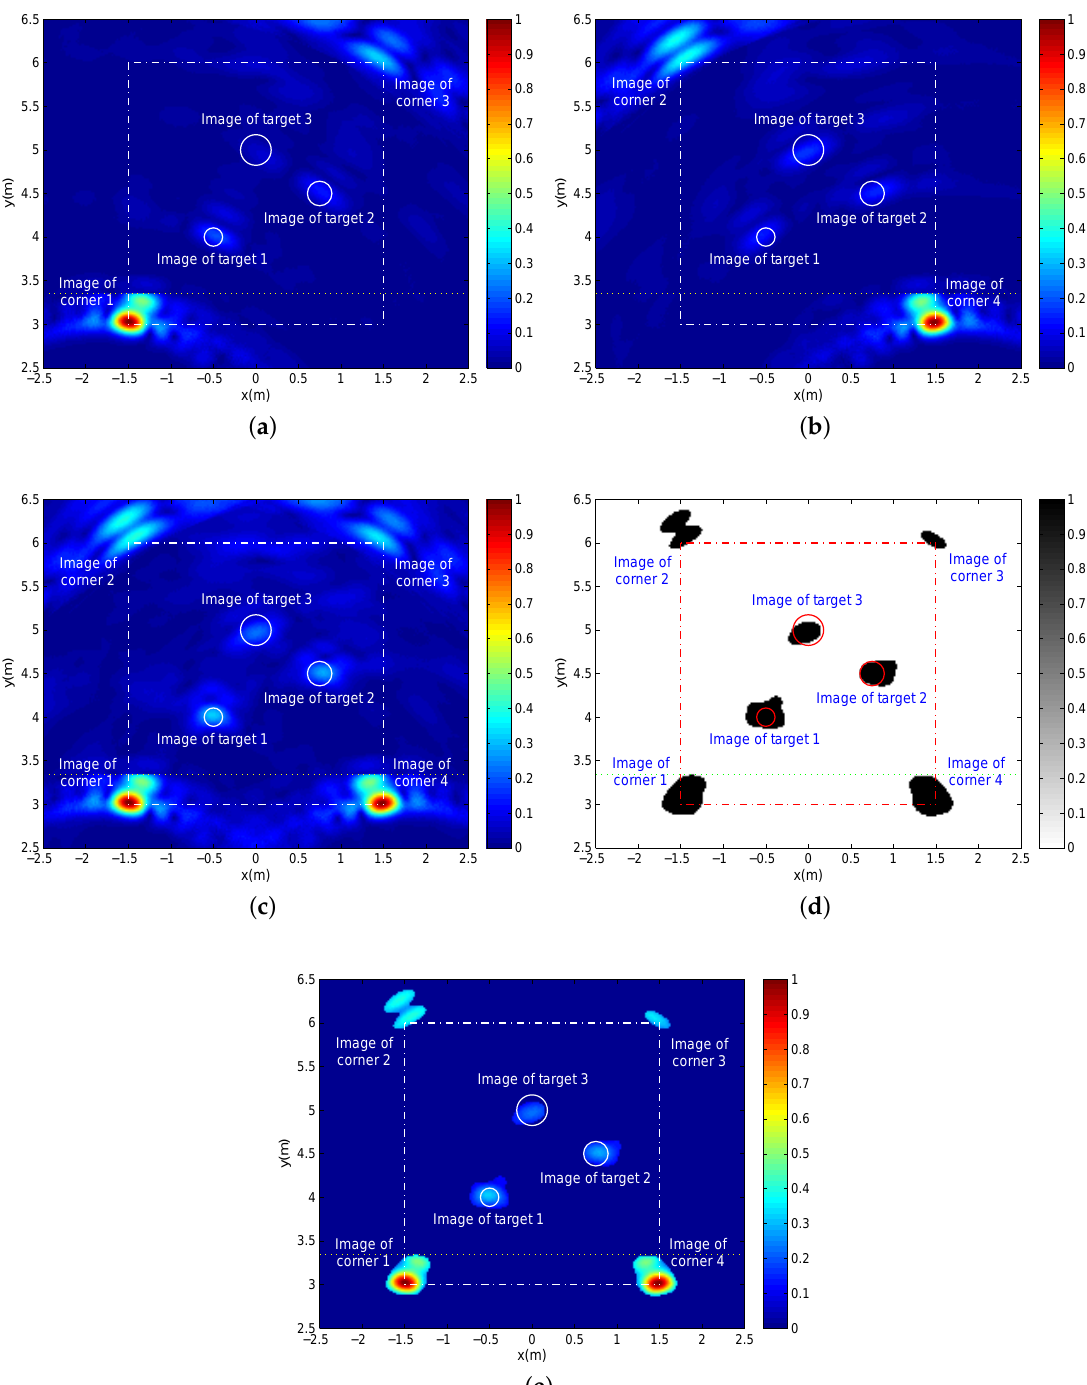
Figure 11. With the two-transmitting six-receiving (2T6R) array of 72 cm in length, ( a , b ) are two single-location images corresponding to Location A and Location B, respectively; ( c ) The panorama image after additive fusion; ( d ) The binary panorama image after 2D CA-CFAR with P fa = 0.0005, 61 × 61 reference window and 37 × 37 protection pixels; ( e ) The panorama image with the original pixel values after 2D CA-CFAR